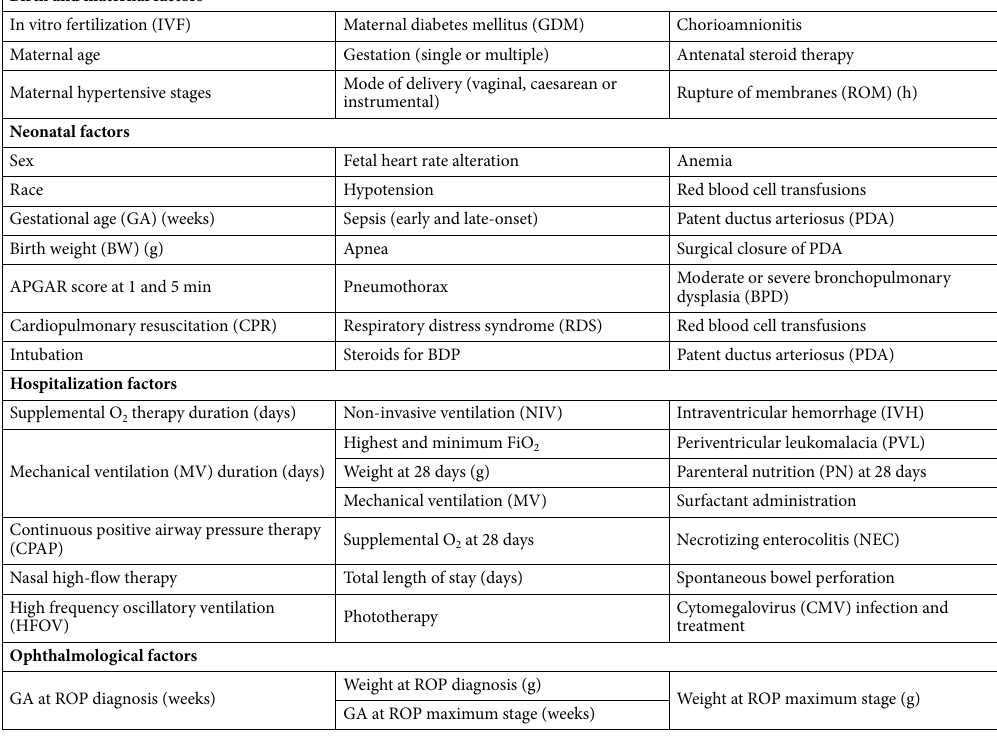
Table 1. Potential risk factors for development and progression of